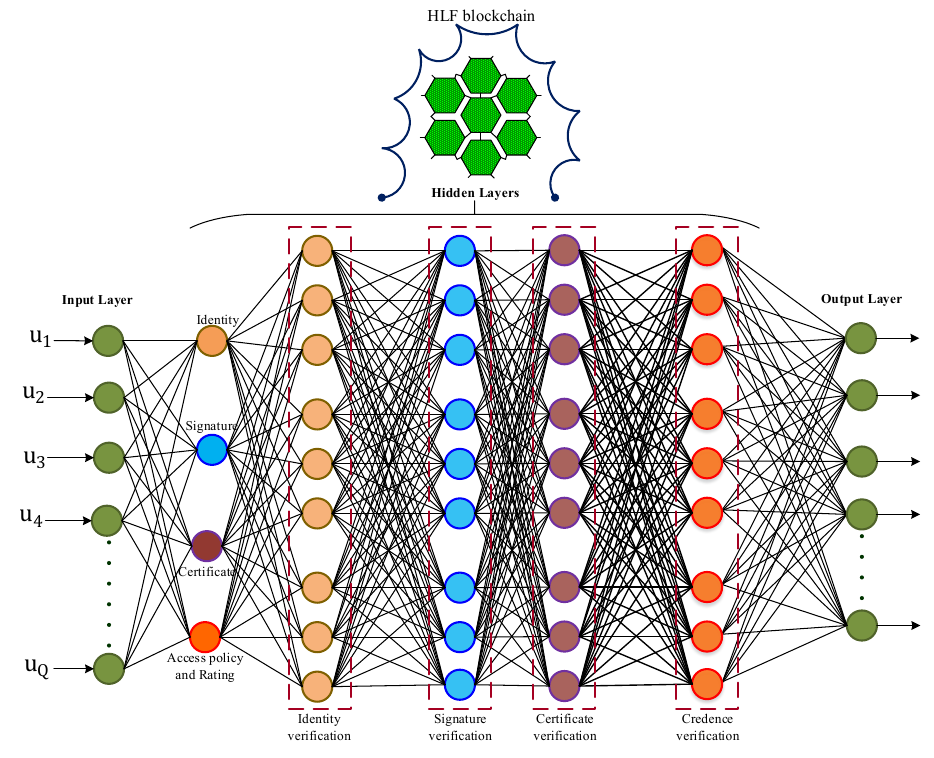
Figure 6. Neural Network for DU